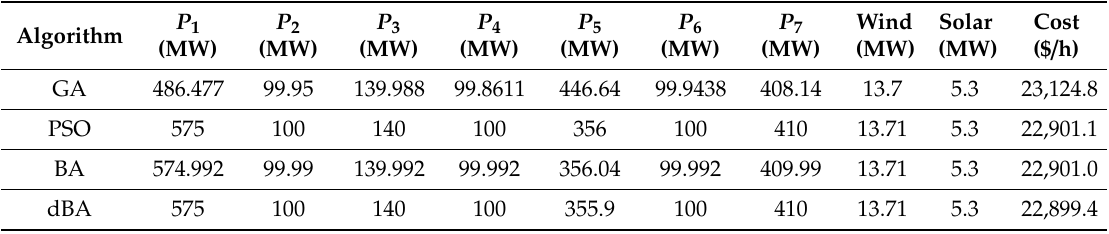
Table 6. Cost comparison for 1800 MW demand with